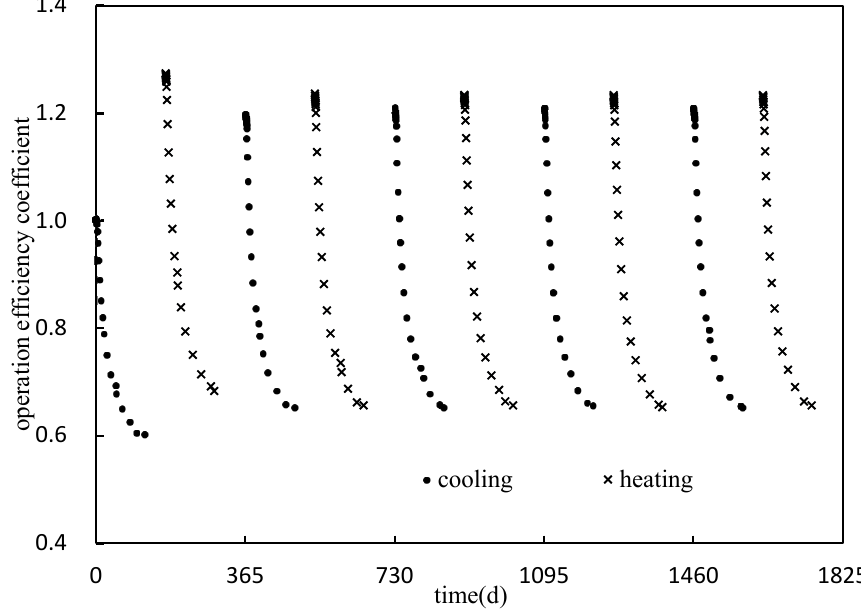
Figure 7. The relationship between operation efficiency coefficient 𝜂 and time for the present operation (F1).